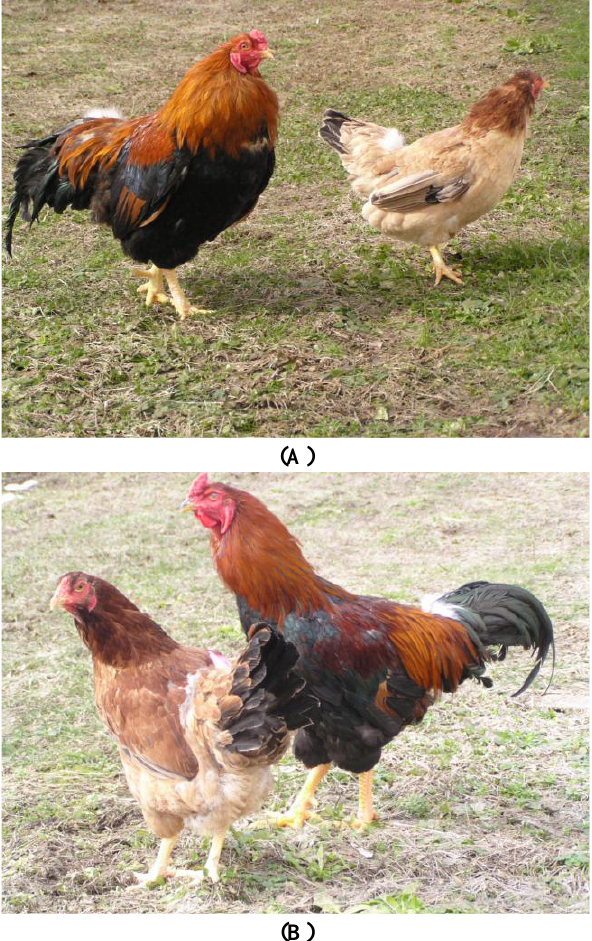
Figure 1. Hinai-dori. (A) Hinai-dori chickens of the Preservation Society (PS) line. Left, male; right, female. (B) Hinai-dori chickens of the Akita Prefectural Livestock Experiment Station (LES) line. Left, female; right,